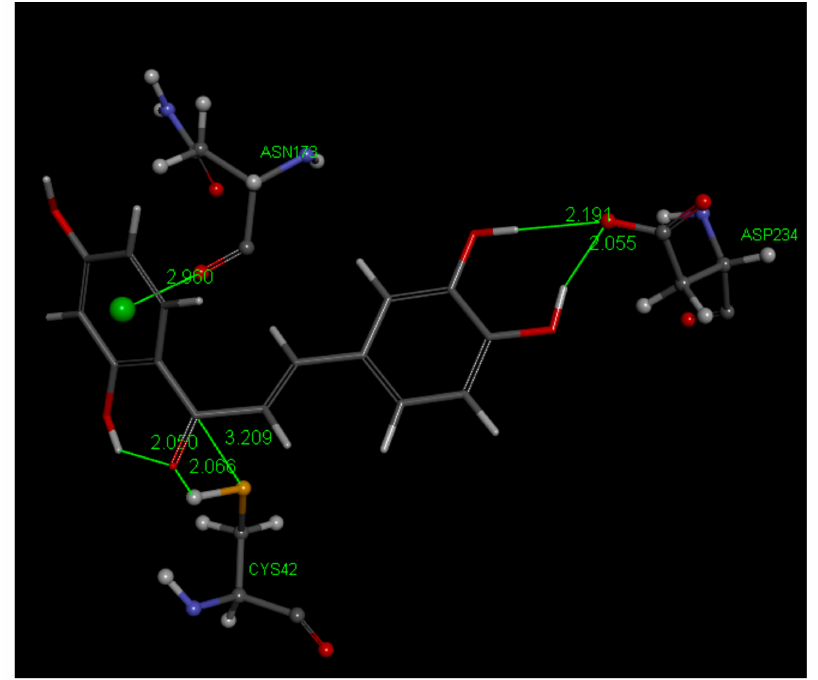
Figure 18. Pose 1 after docking Butein ( 1 ) in the 3BPF